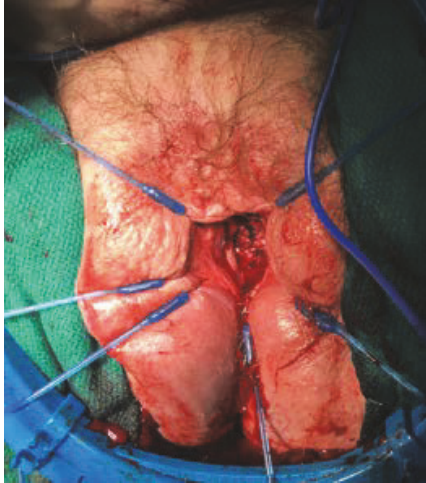
Figure 1: Patulous urethra is clearly observed circumferentially surrounding the Foley catheter.